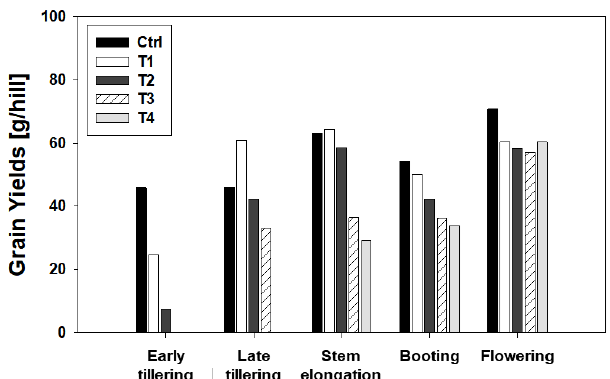
Figure 9. Rice grain yield-based damage assessment of rice after toluene exposure. Grain yield was measured at 130 days after planting (DAP). Table 3. Grain yield and yield components of the control group and toluene-exposed rice. For spikelet number per panicle (SNPP), the same capital letters refer to the same growth stage. The small letters refer to the significant differences in mean SNPP ( α =